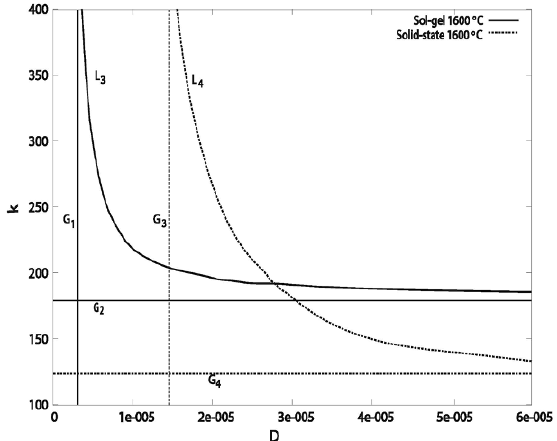
Figure 6. Comparison of lower bounds for sol-gel and solid-state two-dimensional models at